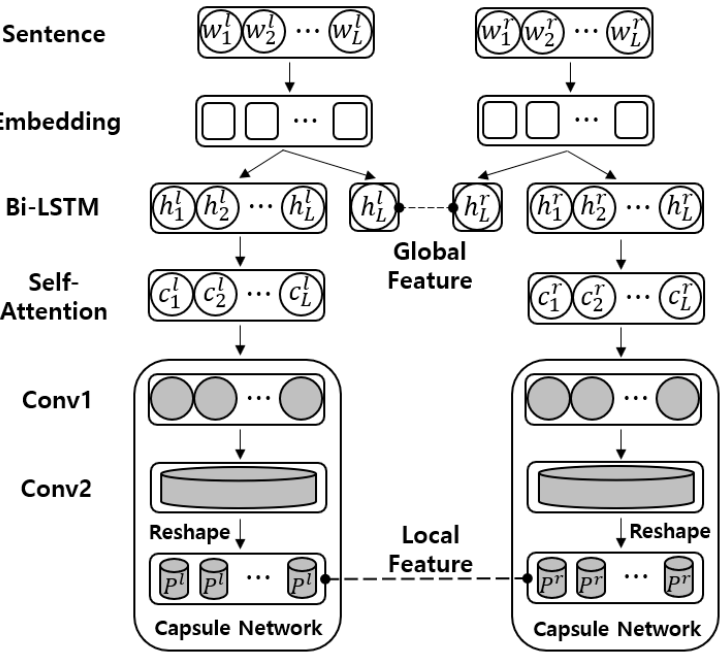
Figure 1. Model of global and local features extraction for semantic similarity evaluation.